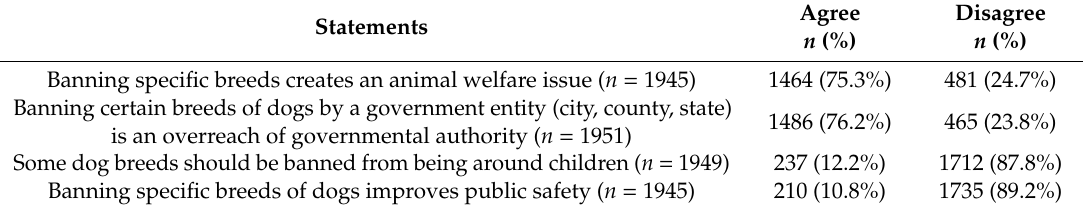
Table 3. Perceptions of breed ban legislation.